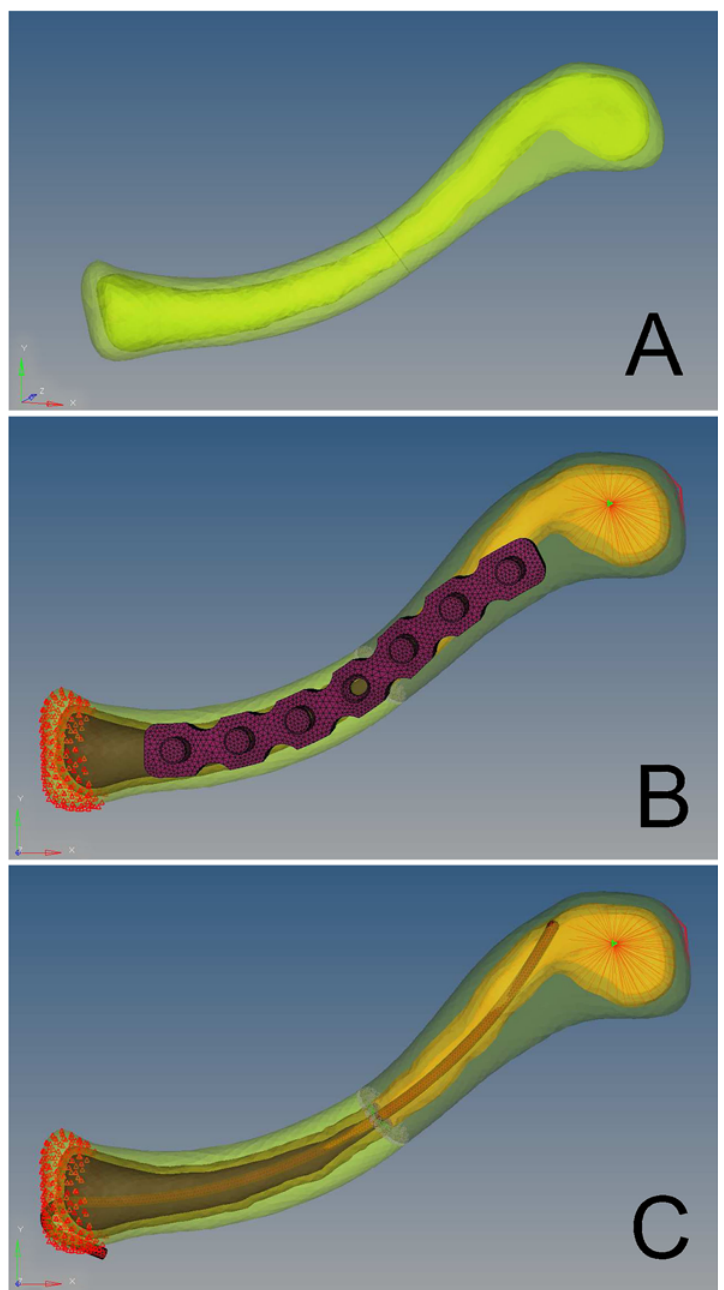
Fig 2. Finite element models. (A) intact clavicle. (B) midshaft clavicular fractures fixed with a reconstruction plate. (C) midshaft clavicular fractures fixed with titanium elastic